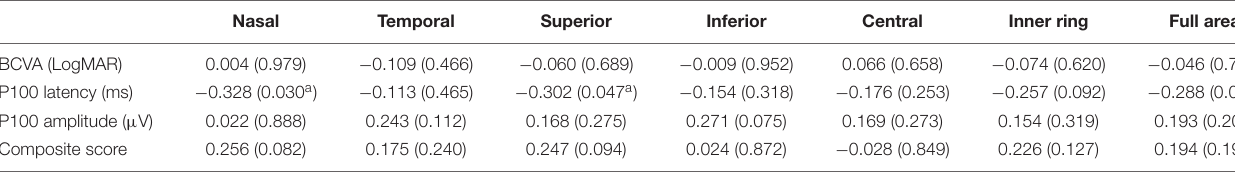
TABLE 5 | Correlations between visual function and macular microvascular density in the 3-mm-diameter region. Nasal Temporal Superior